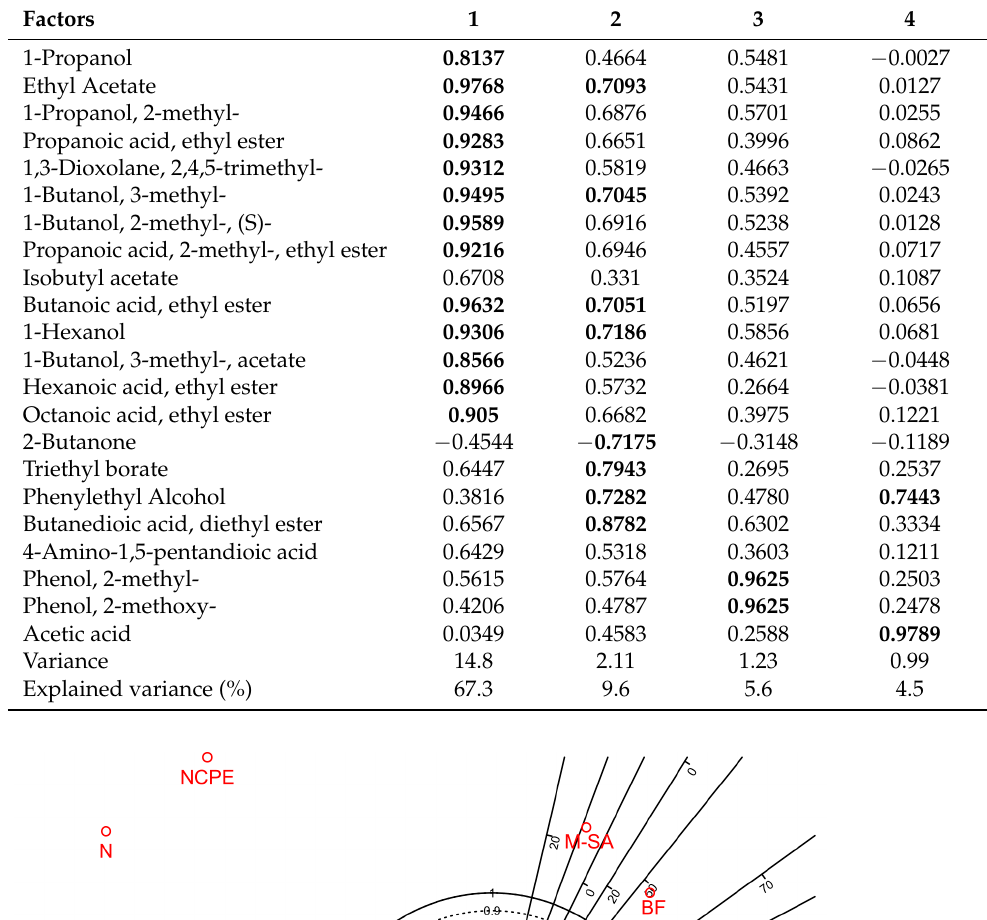
Table 13. Factor loadings for twenty-two volatile organic compounds (VOCs) of white wine calculated from principal axis factor analysis (Varimax rotation). Factor loadings above 0.695 were significant at p = 0.05. Bold figures represent the significant ( p < 0.05) factor loadings.